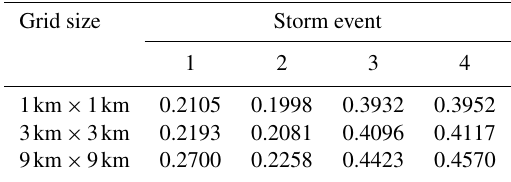
Table 7. Simulation results of the coupled atmospheric–hydrologic systems for four storm events.